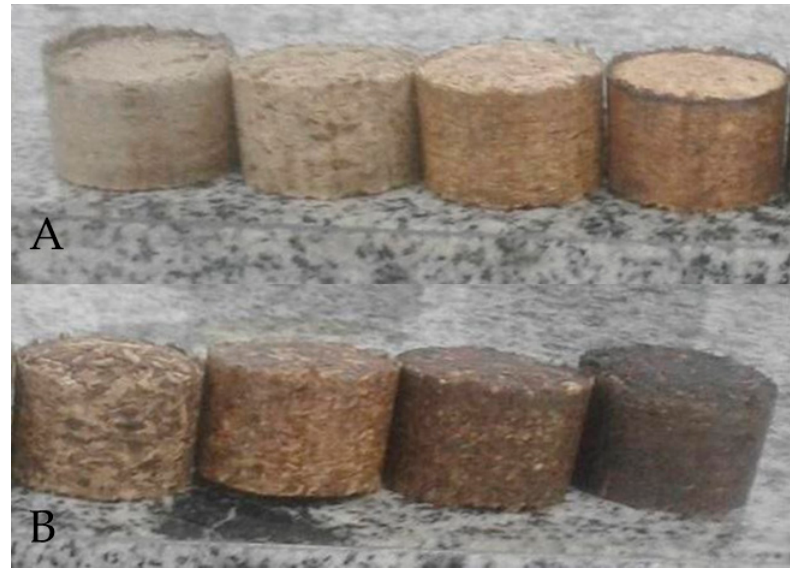
Figure 1. Briquettes produced at 10.34 MPa pressure. ( A ) = Briquettes produced from fresh biomass, left to right: bagasse, co ff ee, eucalyptus, and pine. ( B ) = Briquettes produced from torrefied biomass, from left to right: coffee, eucalyptus, pine, and sugarcane bagasse.